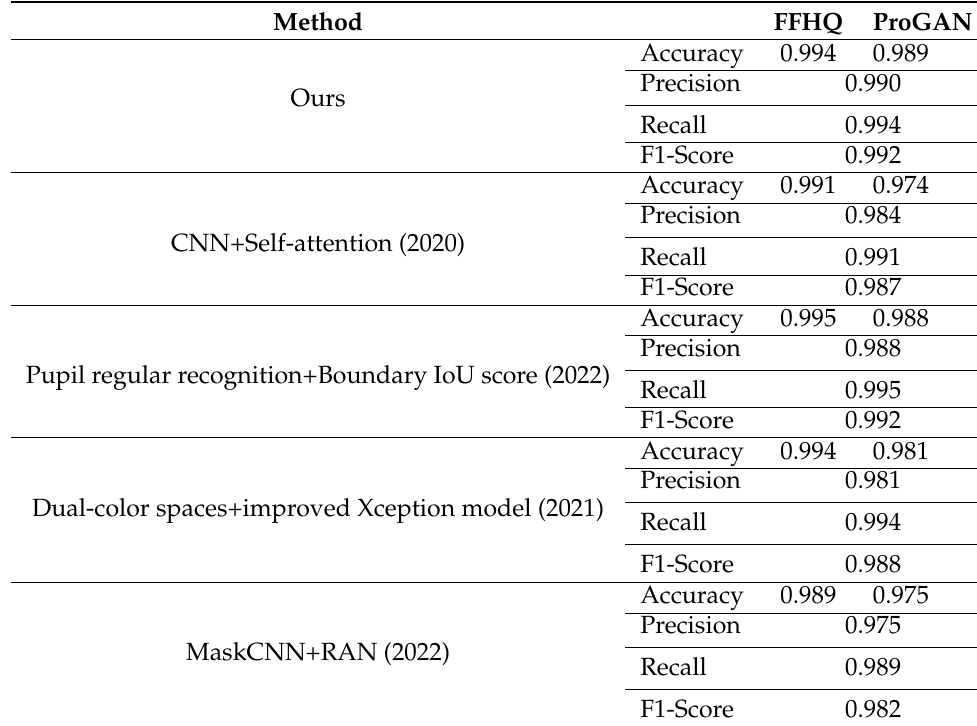
Table 2. Result 1: performance of the source